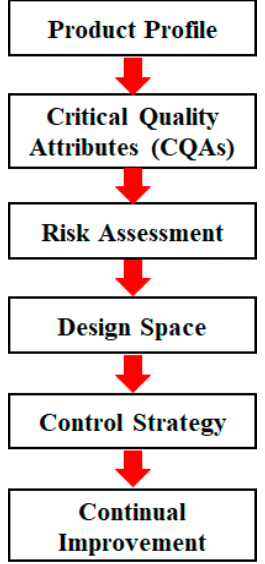
Figure 1. The steps in the product lifecycle under the QbD framework.